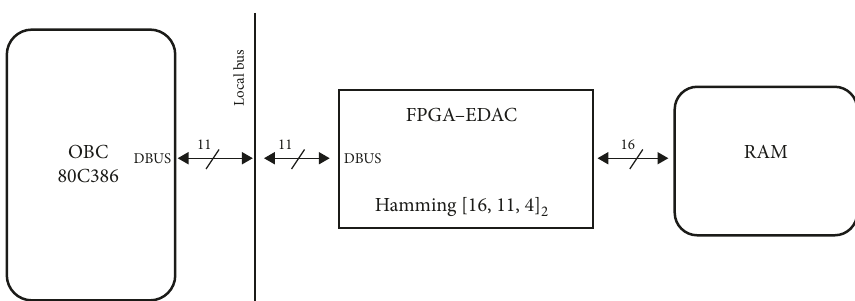
Figure 14: Functional block diagram of Hamming [16, 11, 4]